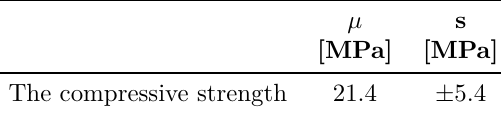
Table 3. Summarization of evaluated compressive strength. The symbol µ denotes the mean value and s is the standard